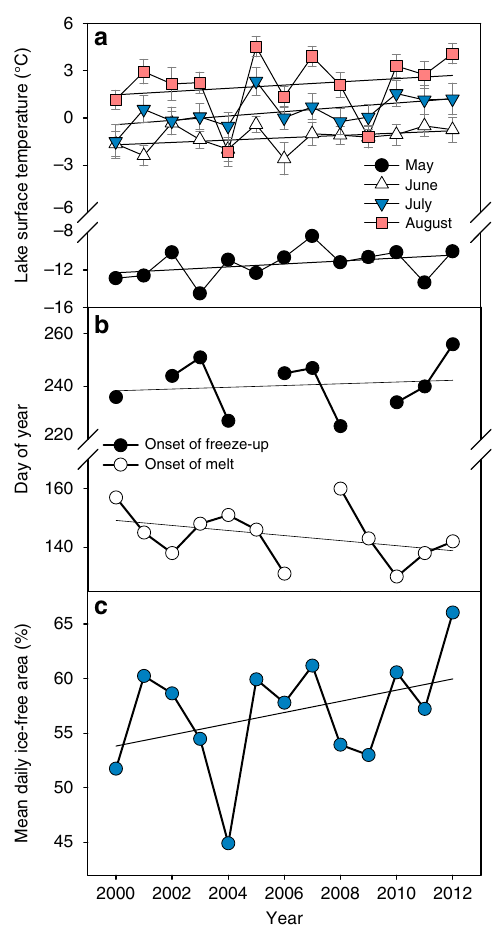
Fig. 3 Temporal trends in surface temperature, ice phenology and ice cover at Lake Hazen. a Monthly mean (±SE) lake surface temperatures (°C) measured at 30 sites on Lake Hazen. b Onset dates (day of year) of melt and freeze-up. c Mean daily ice-free area (% of total lake area) on Lake Hazen between May 5 and September 5. For illustrative purposes, linear trend lines are shown, though none are signi fi cant ( p >